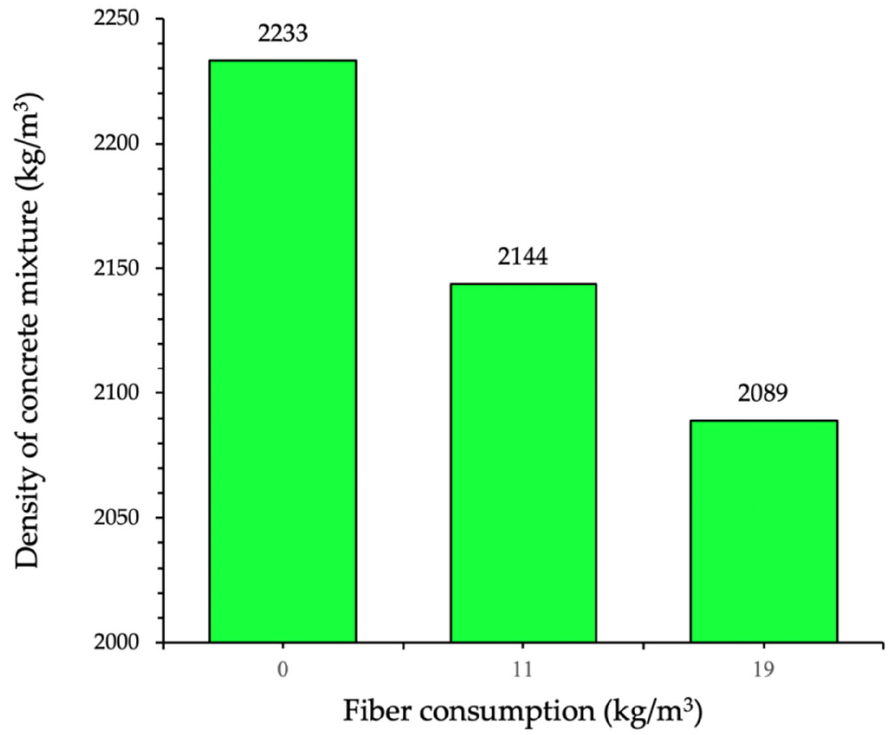
Figure 7. Influence of untreated fiber content on density of concrete mixture.